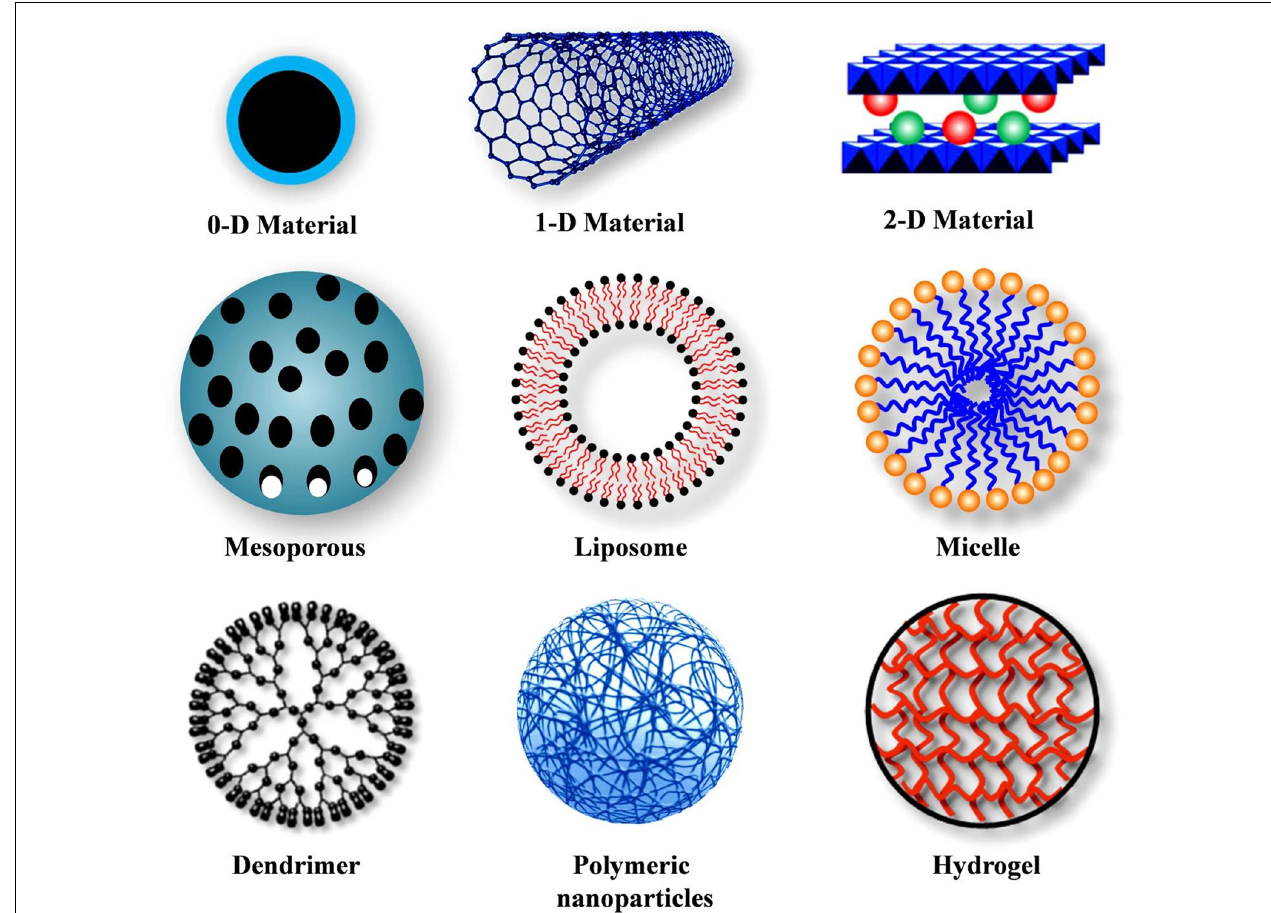
FIGURE 1 | Different types of nanocarriers. Reproduced with permission (Senapati et al.,